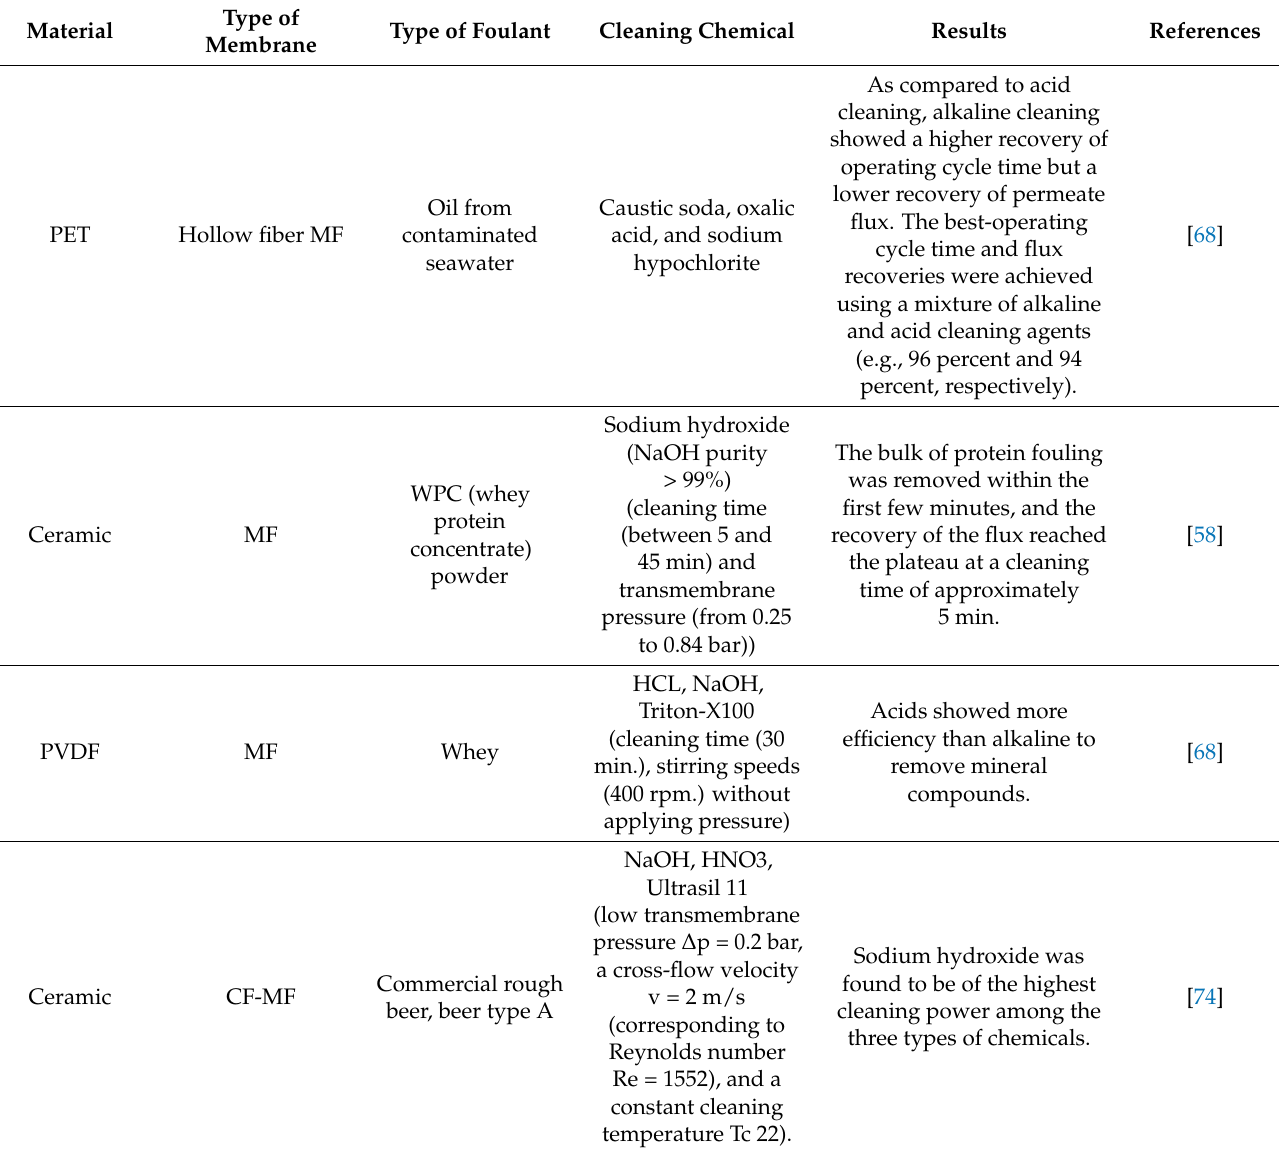
Table 7. Membrane types and chemical